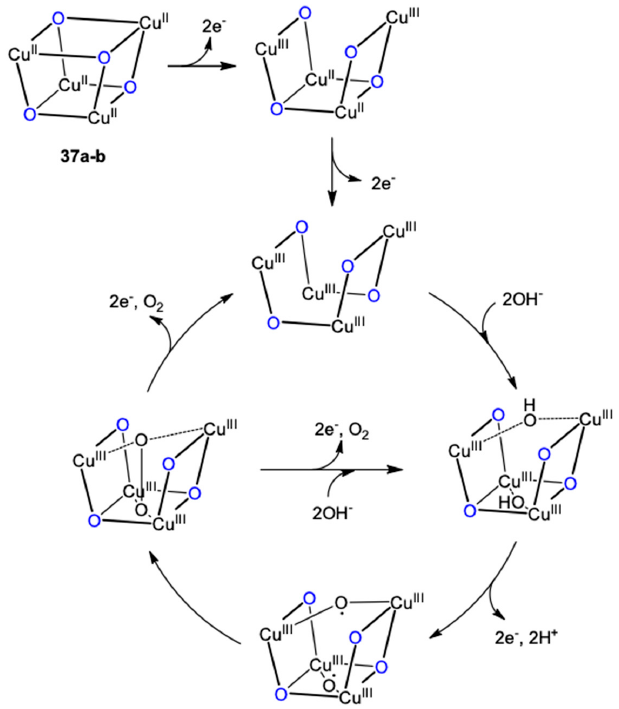
Figure 23. Proposed WOC mechanism for the cubane-like copper clusters [90].